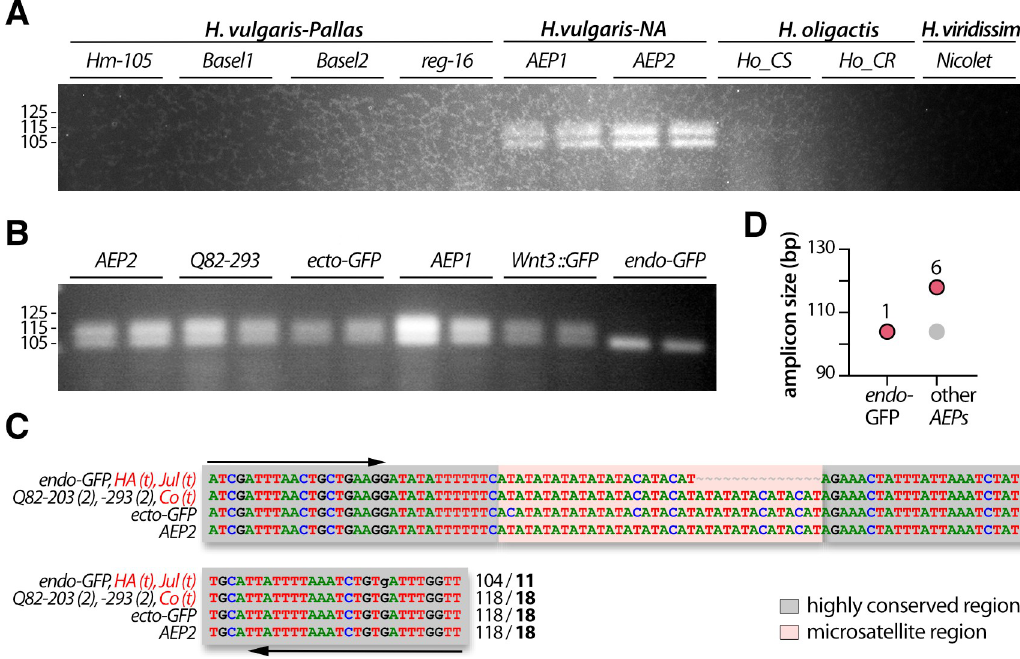
Fig 6. Analysis of the polymorphism of the AT-rich microsatellite detected in the Cyclin-D-Binding Myb-Like Transcription Factor 1 gene (ms-DMTF1) . (A, B) Amplification of the ms-DMTF1 genomic sequence is restricted to the AEP strains, either unmodified ( AEP1 , AEP2 ) or transgenic ( Q82-293 , ecto-GFP , Wnt3 :: GFP , endo-GFP ) lines. (C) Alignment of the ms-DMTF1 sequences. The color boxes indicate the AT-rich central region (salmon-pink) embedded within highly conserved regions (grey). Primer sequences used for amplification are indicated with black arrows. Numbers in brackets after the strain name indicate the number of independent positive sequencings, numbers at the 3’ end indicate the size of the PCR product and the number of AT- repeats (bold). Red writings indicate transcriptomic (t) or genomic (g) sequences available on HydrATLAS (HA) server [32, 40, 41], NHGRI web portal for the Hydra 2.0 genome (g2.0) [34] and Juliano transcriptomes (Jul) [38], or Compagen (Co) server [37, 42] (see S2 Table ). (D) Graphical representation of the size of the ms-DMTF1 amplicons as deduced from sequencing data. Red color dots correspond to expected sizes, the grey dot indicates missing